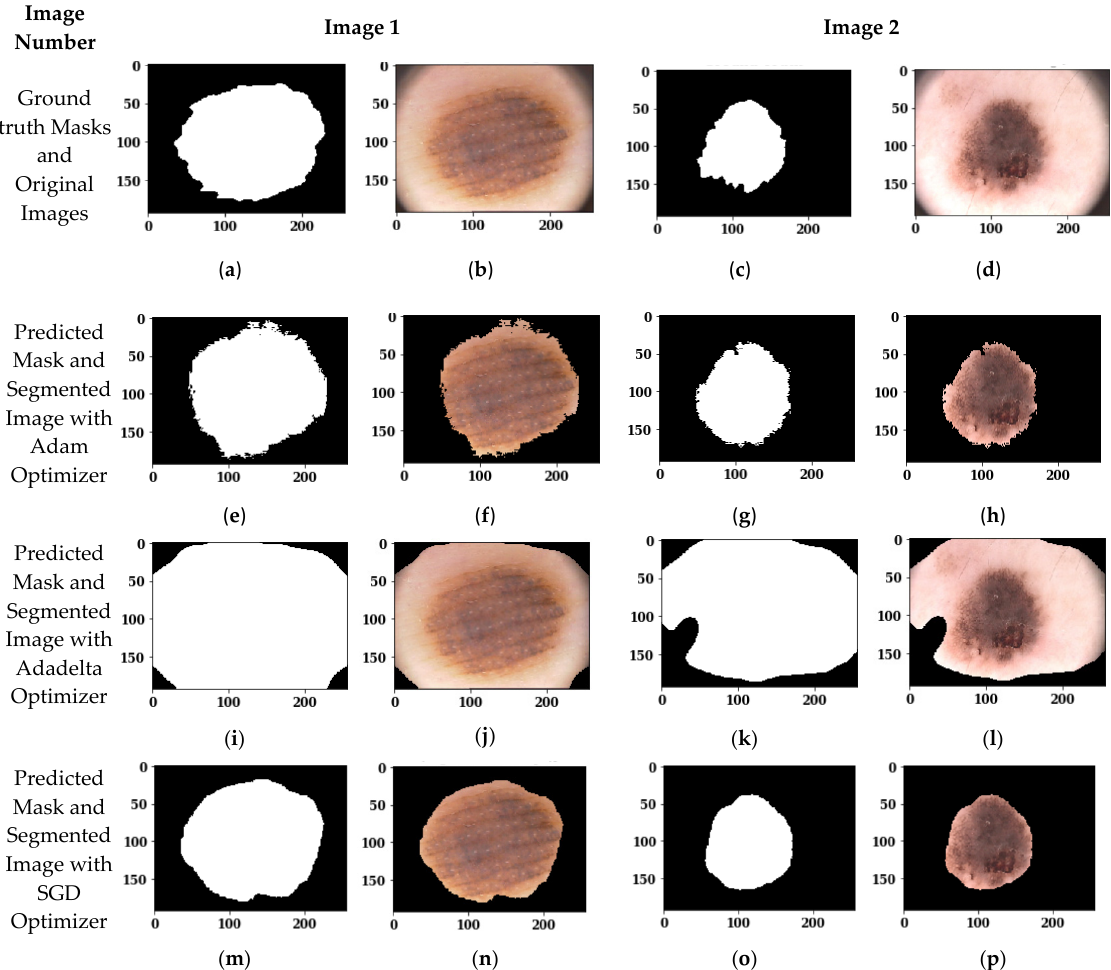
Figure 6. Images segmented with a Batch Size of 18, 100 epochs and different optimizers: ( a ) Ground truth Mask of Original Image 1; ( b ) Original Image 1; ( c ) Ground truth Mask of Original Image 2; ( d ) Original Image 2; ( e ) Predicted Mask of Image 1 with Adam optimizer; ( f ) Segmented Output of Image 1 with Adam optimizer; ( g ) Predicted Mask of Image 2 with Adam optimizer; ( h ) Segmented Output of Image 2 with Adam optimizer and; ( i ) Predicted Mask of Image 1 with Adadelta opti- mizer; ( j ) Segmented Output of Image 1 with Adadelta optimizer; ( k ) Predicted Mask of Image 2 with Adadelta optimizer; ( l ) Segmented Output of Image 2 with Adadelta optimizer; ( m ) Predicted Mask of Image 1 with SGD optimizer; ( n ) Segmented Output of Image 1 with SGD optimizer; ( o ) Predicted Mask of Image 2 with SGD optimizer; ( p ) Segmented Output of Image 2 with SGD opti- mizer.